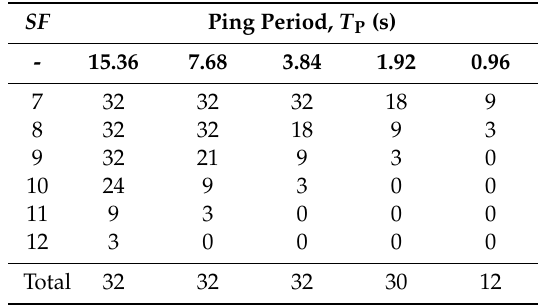
Table 4. Maximum number of coordinated IPSs for each SF (considering the use of all the three compulsory LoRaWAN channels) depending on the selected ping period, in the scenario with up to 32 mapped devices. SF : Spreading